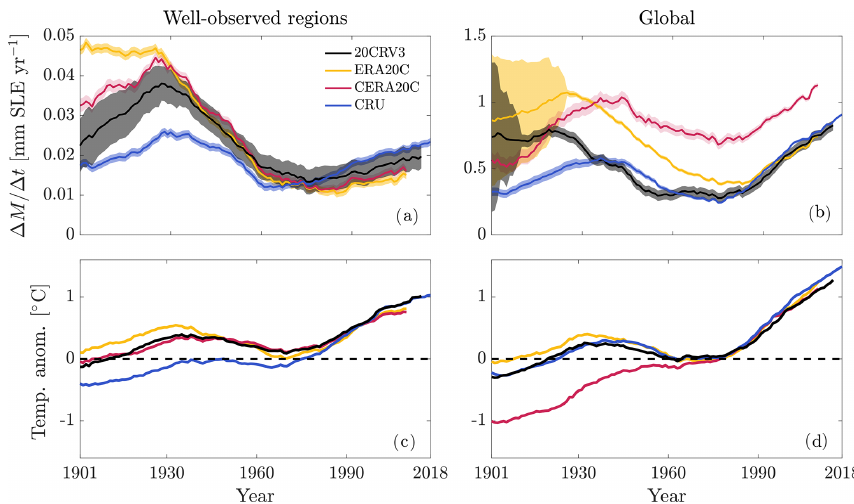
Figure 4. Mass loss rate estimates for meteorological forcing data sets with whole 20th century coverage: (a) averaged over well-observed regions (Western Canada and US, Scandinavia, Central Europe, and Central Asia) and (b) globally. Average temperature anomalies at glacier tongue locations in (c) well-observed regions and (d) globally, weighted by glacier area. In all graphs, 31-year moving averages are shown for